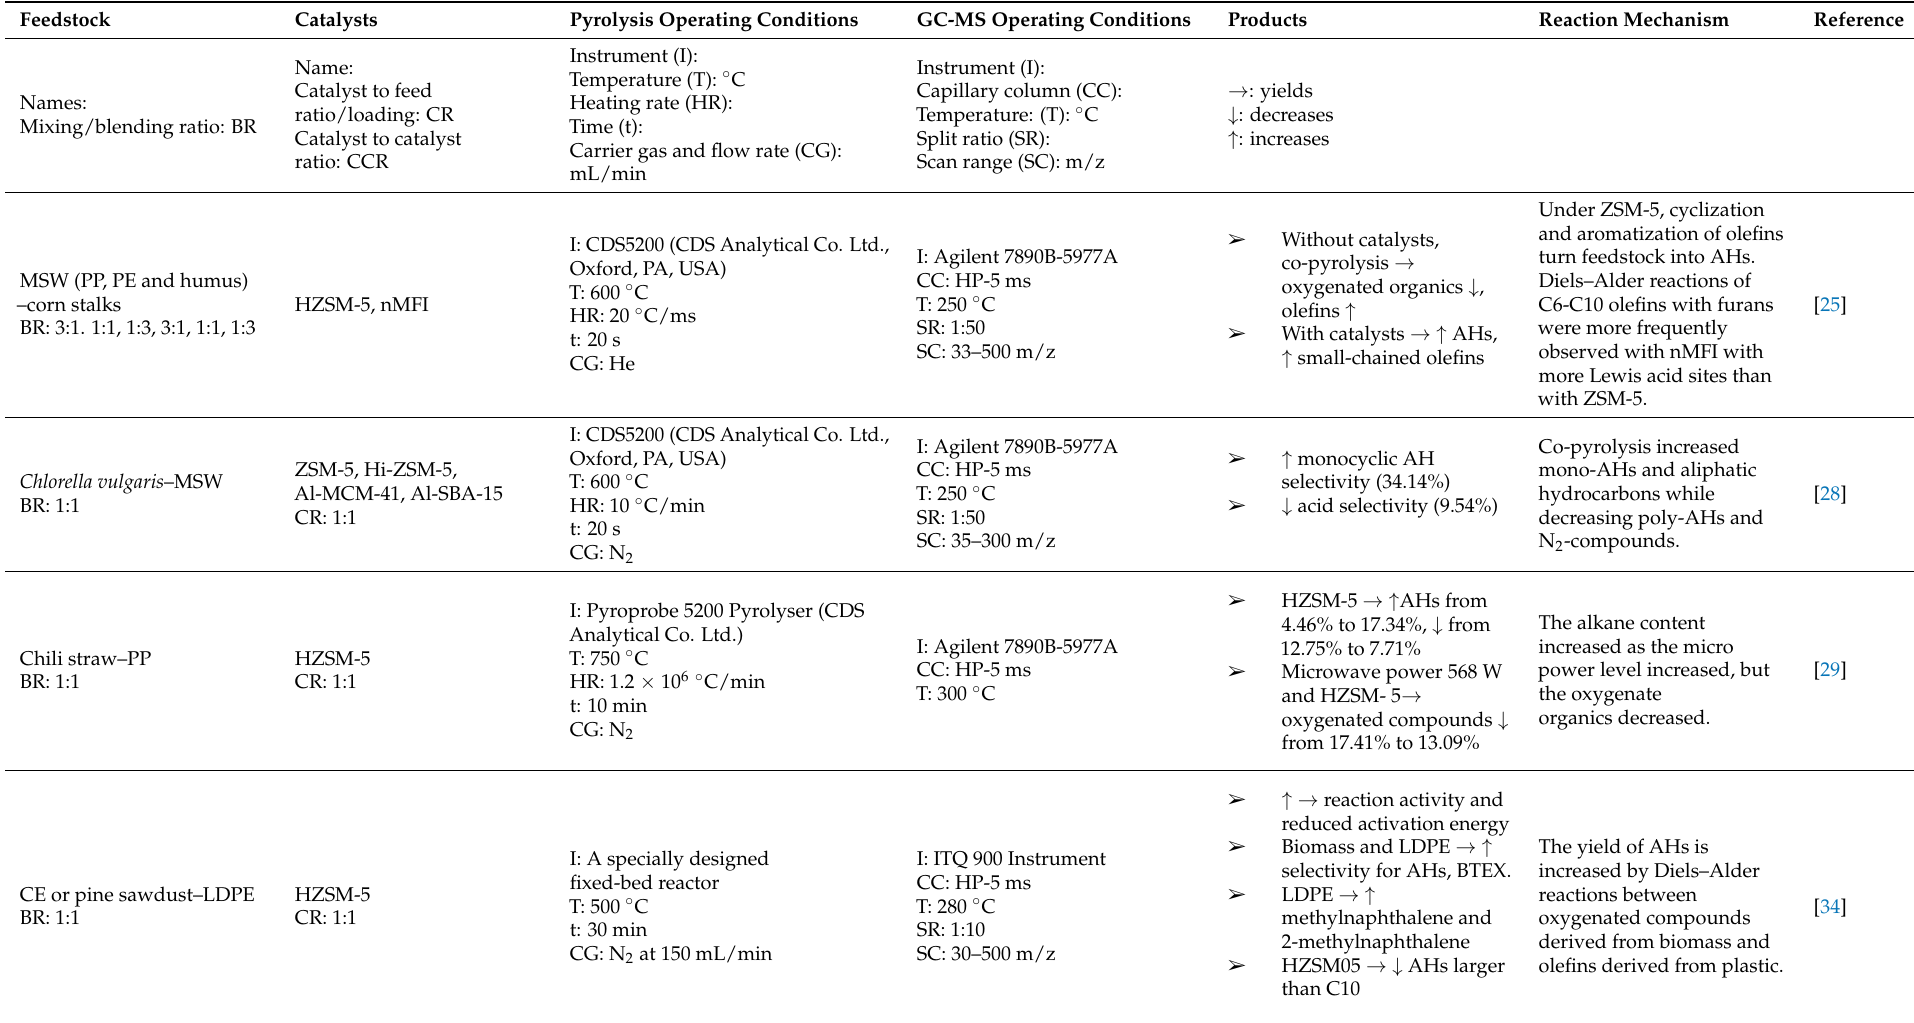
Table 1. Findings of zeolite catalysts from selected articles reviewed in this study. Catalysts Products Reaction Mechanism